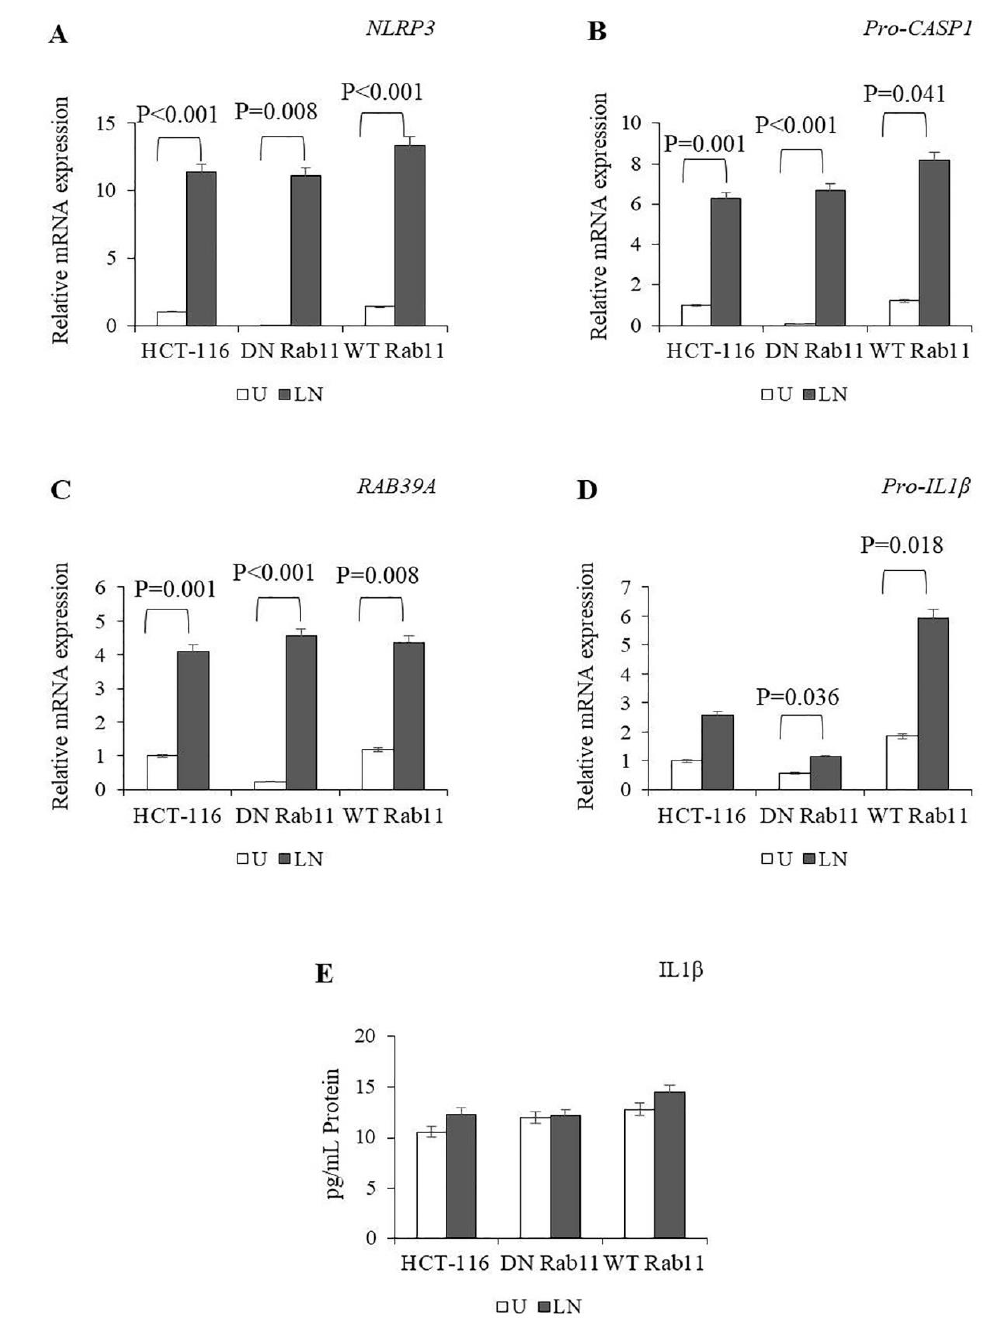
Figure 6. The e ff ects of Rab11 on NALP3 inflammasome activation. To assess NALP3 activation, HCT116 cells transfected with pDsRed-Rab11 WT and pDsRed-Rab11 DN were primed with LPS (1 µ g / mL) for three hours and then treated using nigericin (20 µ M) for 24 h. ( A – D ) The e ff ects of DN Rab11 and WT Rab11 on the expression of NLRP3 , RAB39A , Pro-CASP1 and Pro-IL1 β in the control and LPS / nigericin-treated cells. ( E ) The e ff ects of DN Rab11 and WT Rab11 on IL1 β secretion in the control and LPS / nigericin-treated cells. U: untreated; LN: LPS / nigericin-treated. ( n = 3 for each experiment; p -values were calculated using independent sample T test).